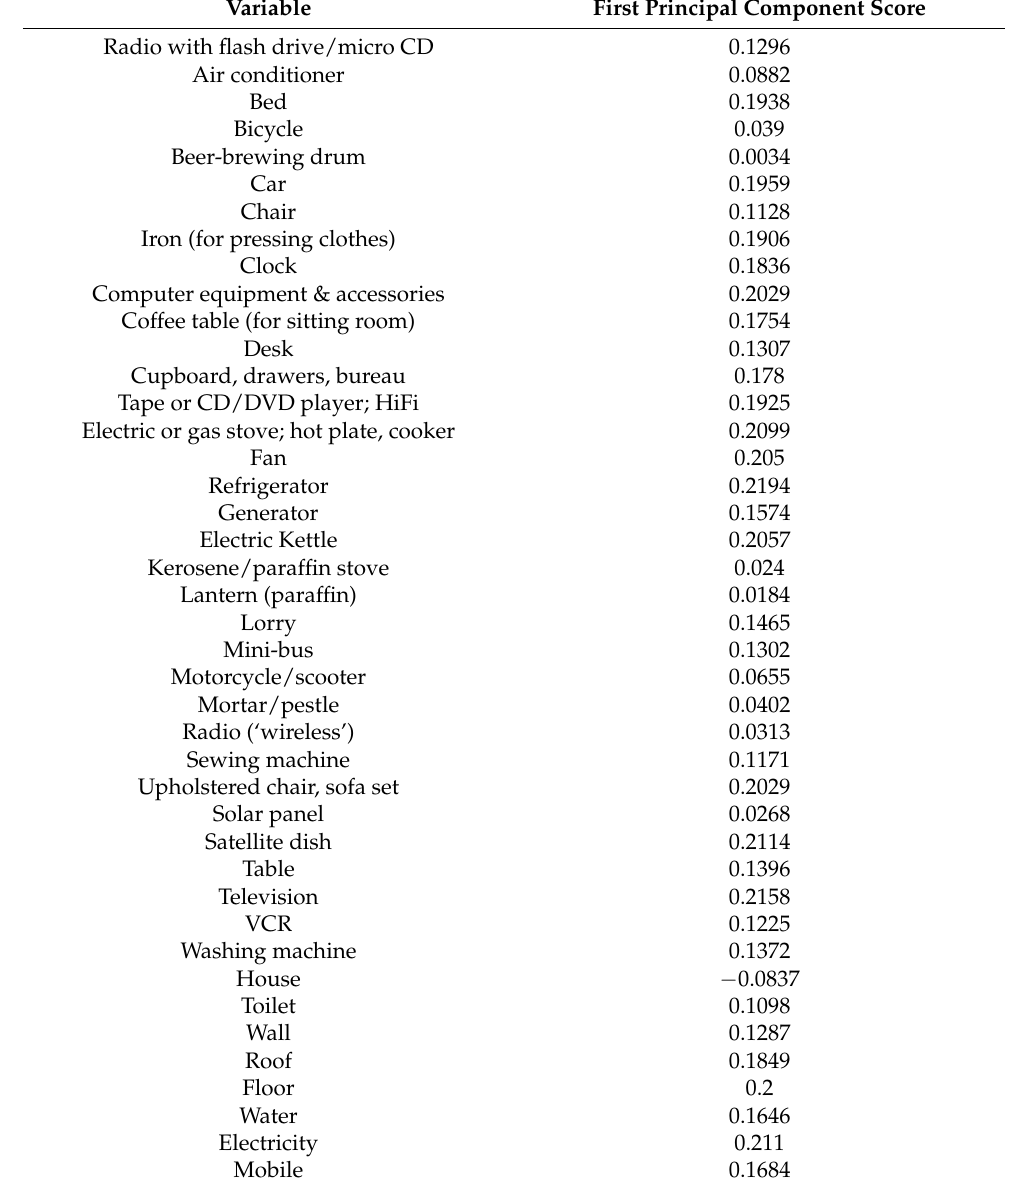
Table A2. Asset index for Malawi- Results from tetrachoric Principal Components Analysis.